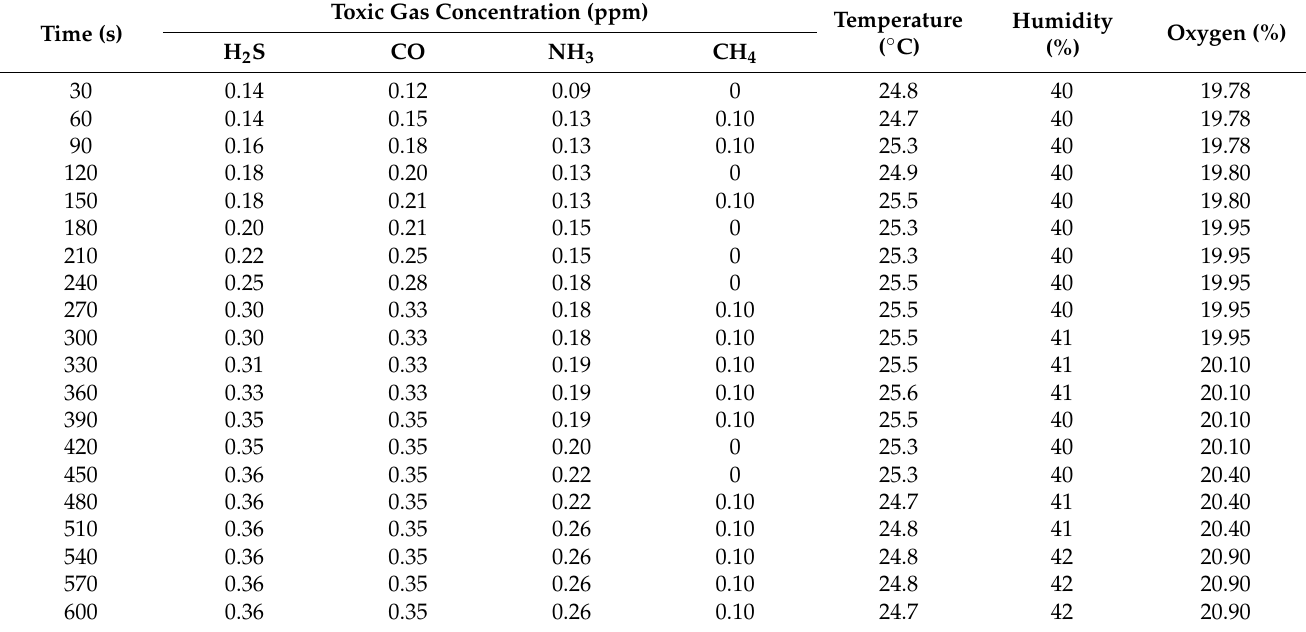
Table 2. Result of data obtained from the helmet-mounted system in the normal environment.